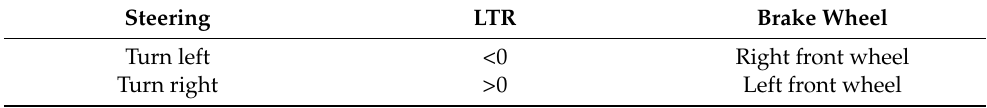
Table 5. Braking torque distribution strategy.